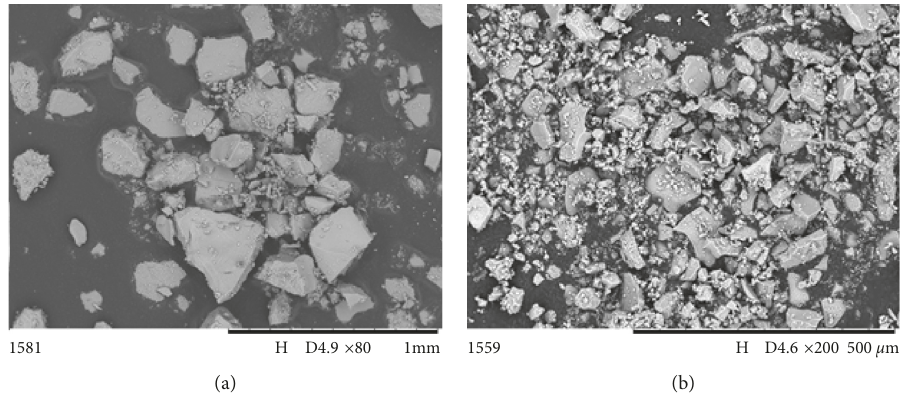
Figure 18: CaF 2 particles after precipitation in the Koflo static mixer: (a) Re